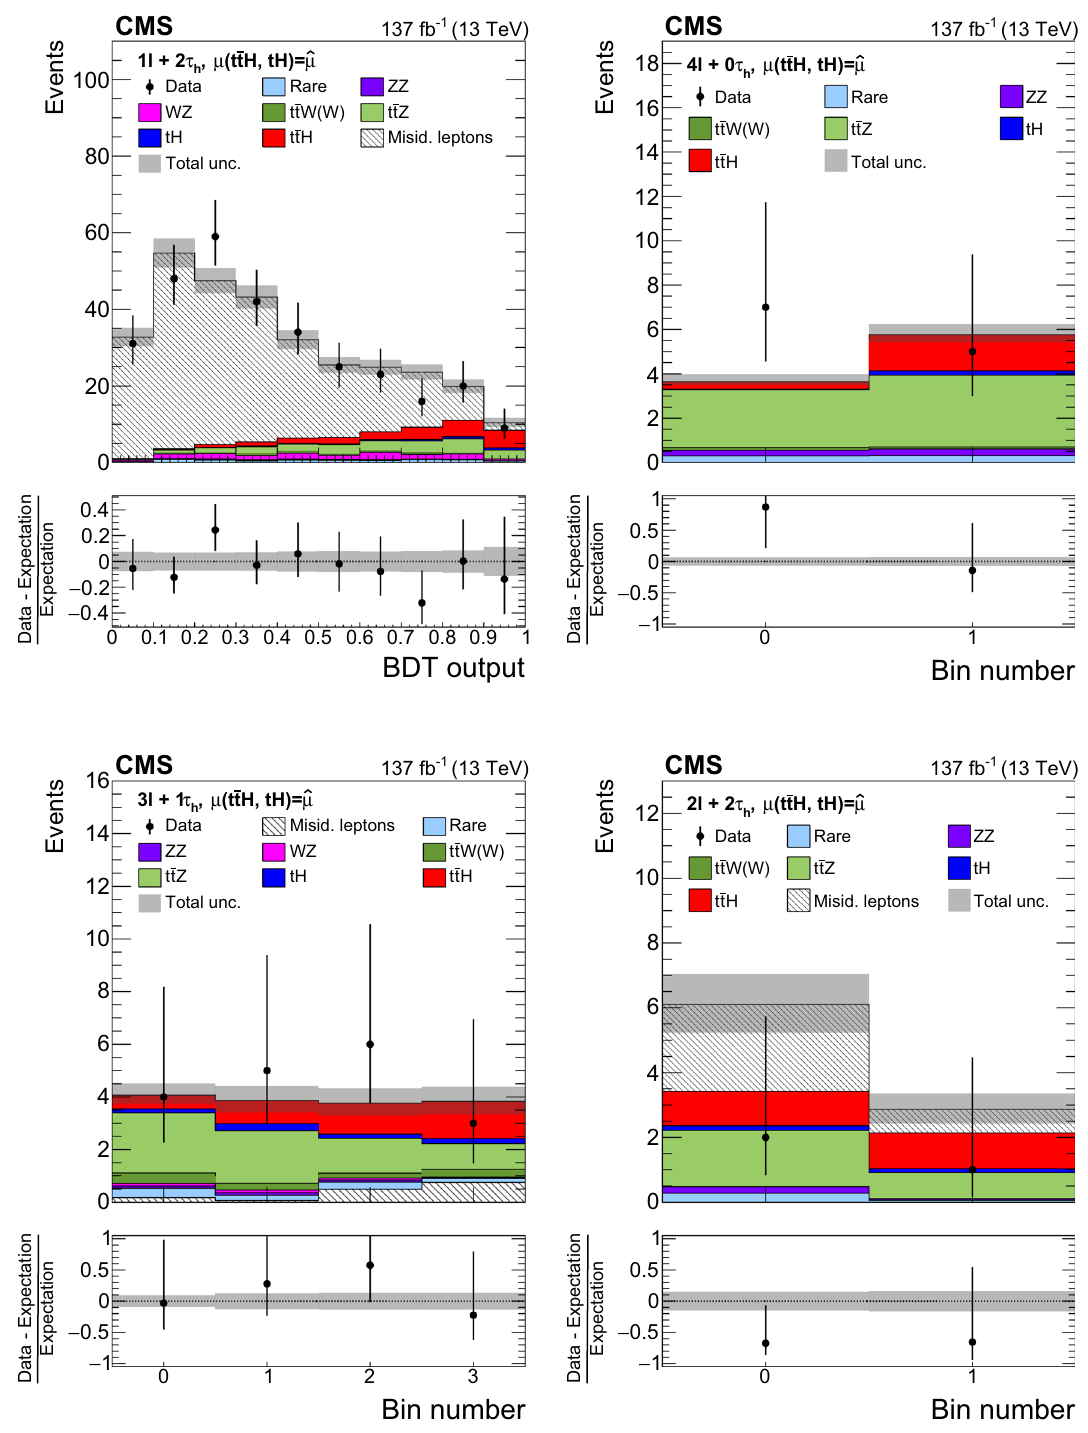
Fig. 11 Distributions of the BDT output used for the signal extraction in the 1 (cid:4) + 2 τ h (upper left), 4 (cid:4) + 0 τ h (upper right), 3 (cid:4) + 1 τ h (lower left), and 2 (cid:4) + 2 τ h (lower right) channels. The distributions expected for the ttH and tH signals and for background processes are shown for